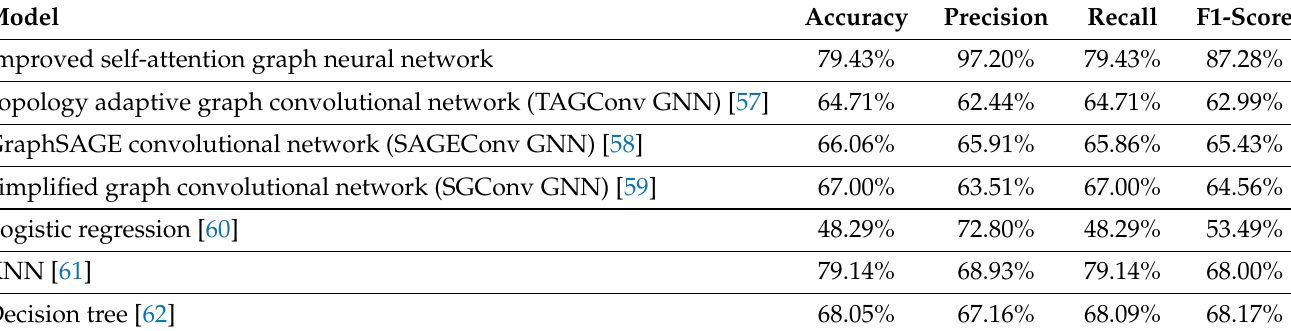
Table 5. The three-category classification results on the test